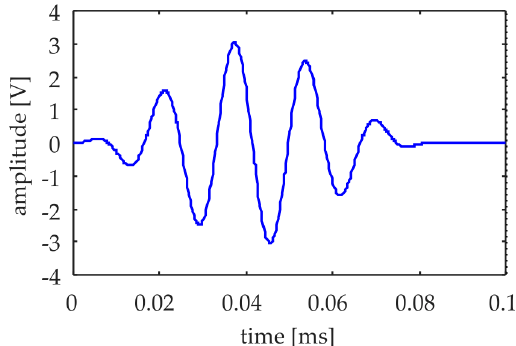
Figure 4. Excitation signal.